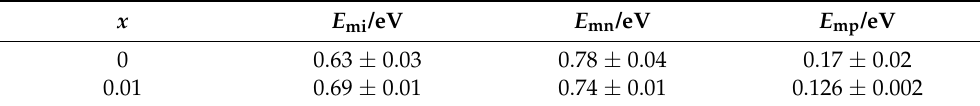
Figure 12. Mobility of oxygen ions, holes, and electrons in La 0.5 − x Sr 0.5 FeO 3 − δ ( x = 0 and 0.01) as a function of oxygen content in oxides at different temperatures. Table 4. The migration energy values for oxygen ions, electrons, and holes in La 0.5 − x Sr 0.5 FeO 3 − δ .